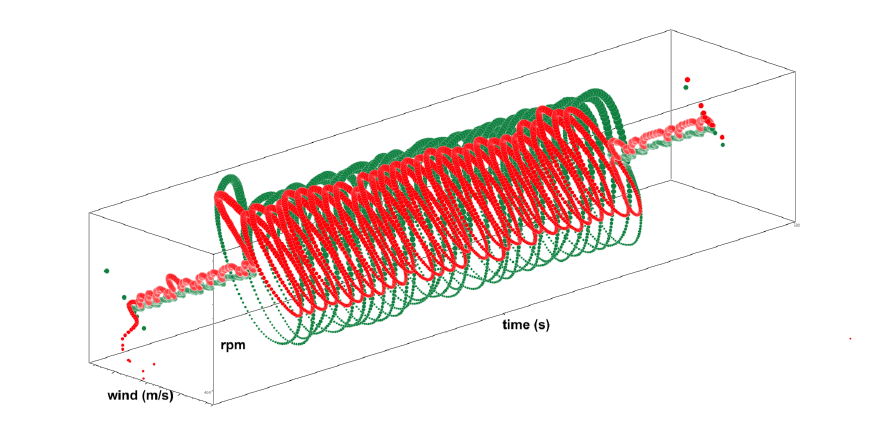
Figure 10. Comparison of the experimental (green) and numerical (red) time series of the rotor speed versus wind speed (test